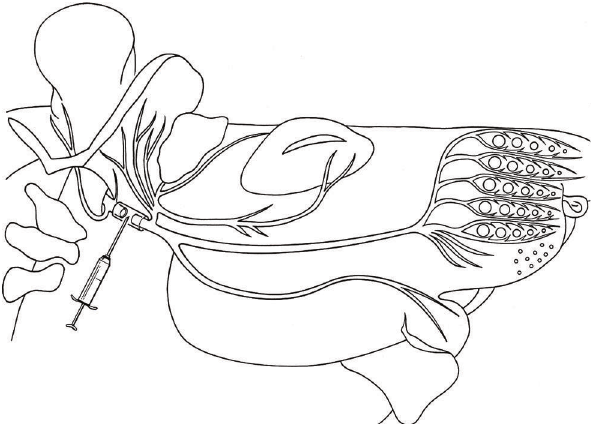
Figure 1: Surgical procedure: entubulation of the facial nerve trunk after transection (adapted from